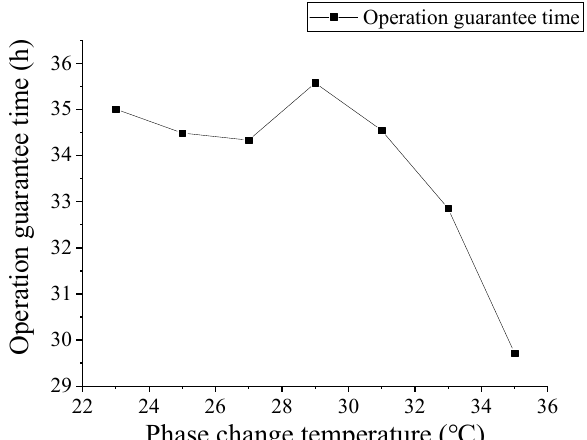
Figure 8. Effect of phase change temperature on the guaranteed operation time of the reservoir.